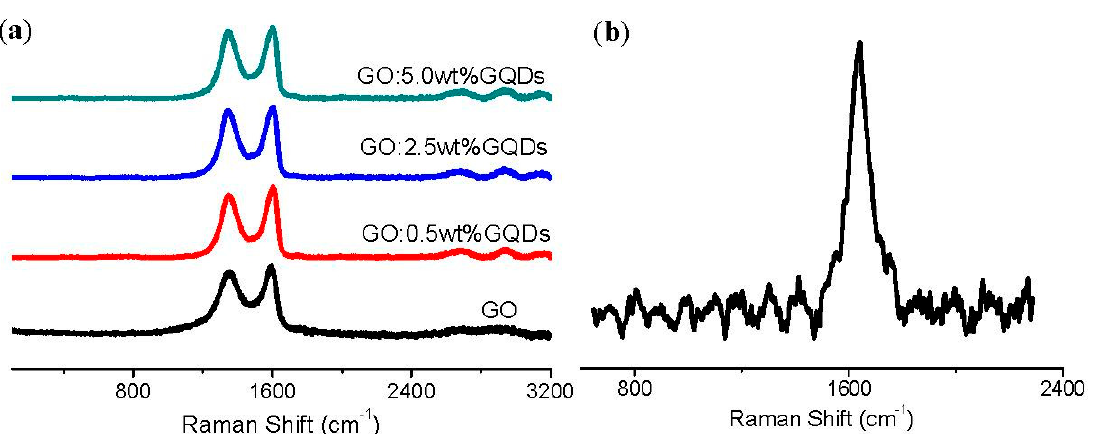
Figure 2. ( a ) Raman spectra of GO and its nanocomposites with different content of GQDs 0.5 wt%,